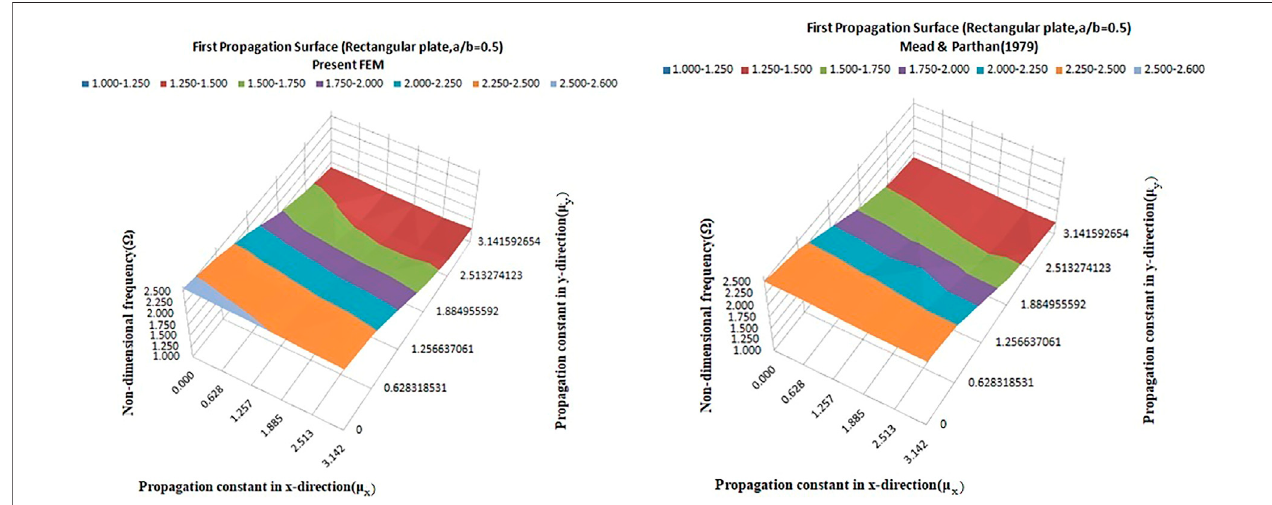
FIGURE 7 | Comparison of the present propagation surface of the periodic rectangular plate using PS-FEM with (Mead and Parthan, 1979).